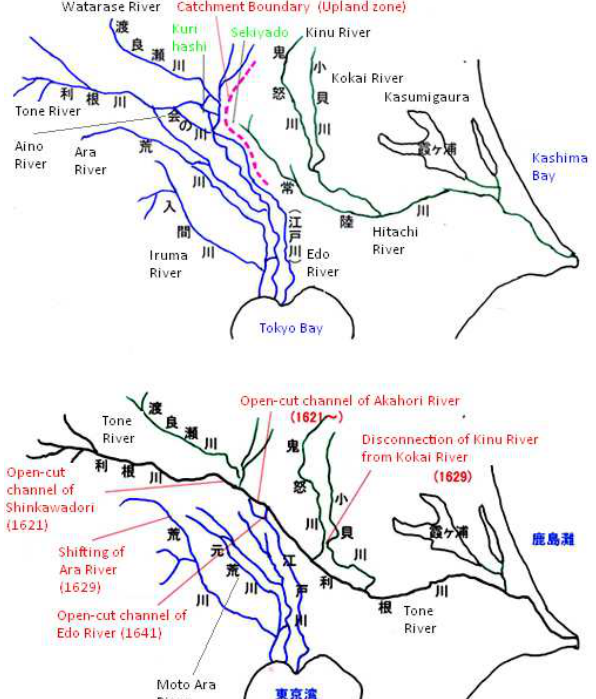
Fig 3: Track of Typhoon Kathleen (modified from Kanto Regional Development Bureau, Ministry of Land, Infrastructure, Transport and Tourism (2011)).